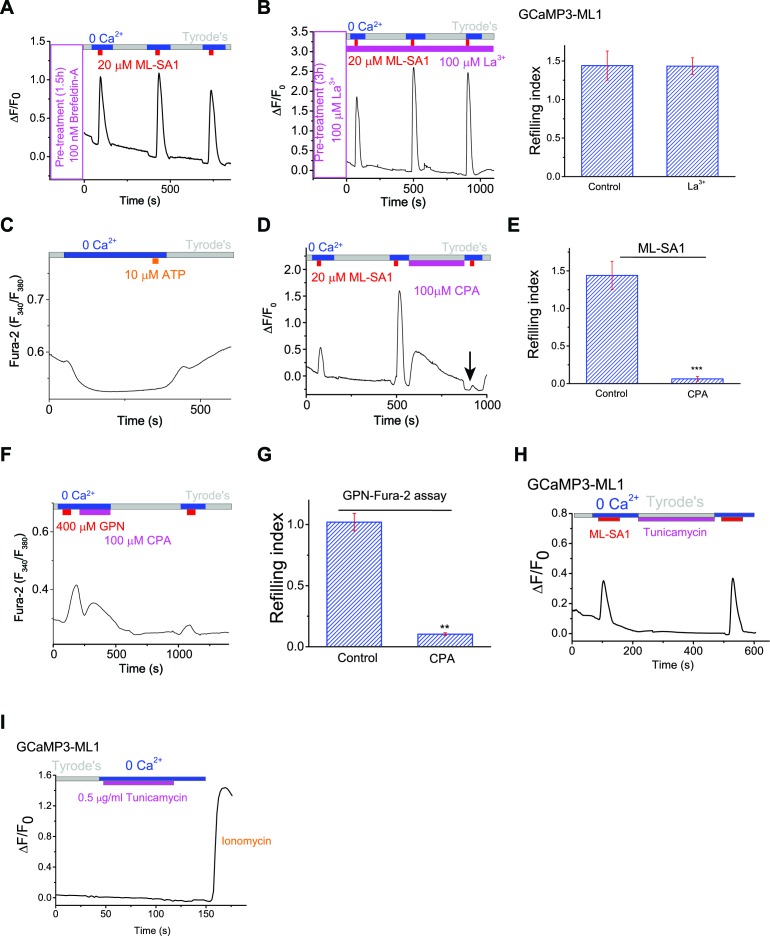
The ER Ca2+ store regulates lysosome Ca2+ stores.(A) The effect of Brefeldin-A (100 nM) pretreatment on lysosomal Ca2+ refilling in HEK-GCaMP3-ML1 cells. (B) The effect of La3+ (100 μM) pre-treatment on lysosomal Ca2+ refilling in HEK-GCaMP3-ML1 cells. (C) The response to the endogenous P2Y receptor agonist ATP in HEK293T cells loaded with Fura-2 was abolished after perfusing cells with 0 external Ca2+ for 5 min. (D, E) SERCA pump inhibitor cyclopiazonic acid (CPA) (100 μM) blocked Ca2+ refilling of lysosomes (Figure 2—source data 1). (F, G) CPA markedly reduced the response to GPN in the Fura-2-loading cells. Note that the remaining response could be due to GPN-induced lysosomal H+ release, which resulted in a change of pre-lysosomal pH that may in turn caused a Fura-2 signal (Figure 2—source data 1). (H) Tunicamycin (0.1 μg/ml) application did not affect the second responses to ML-SA1 in GCaMP3-ML1 cells. (I) Tunicamycin (0.5 μg/ml) did not induce lysosomal Ca2+ releases. Panels A–I and K show the average response of 30–40 cells from one representative experiment.